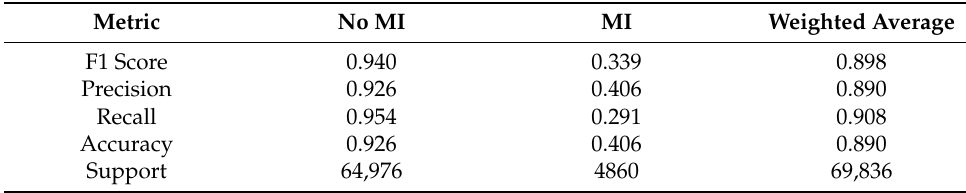
Table 3. Classification results for Model 7 on the unseen test set.